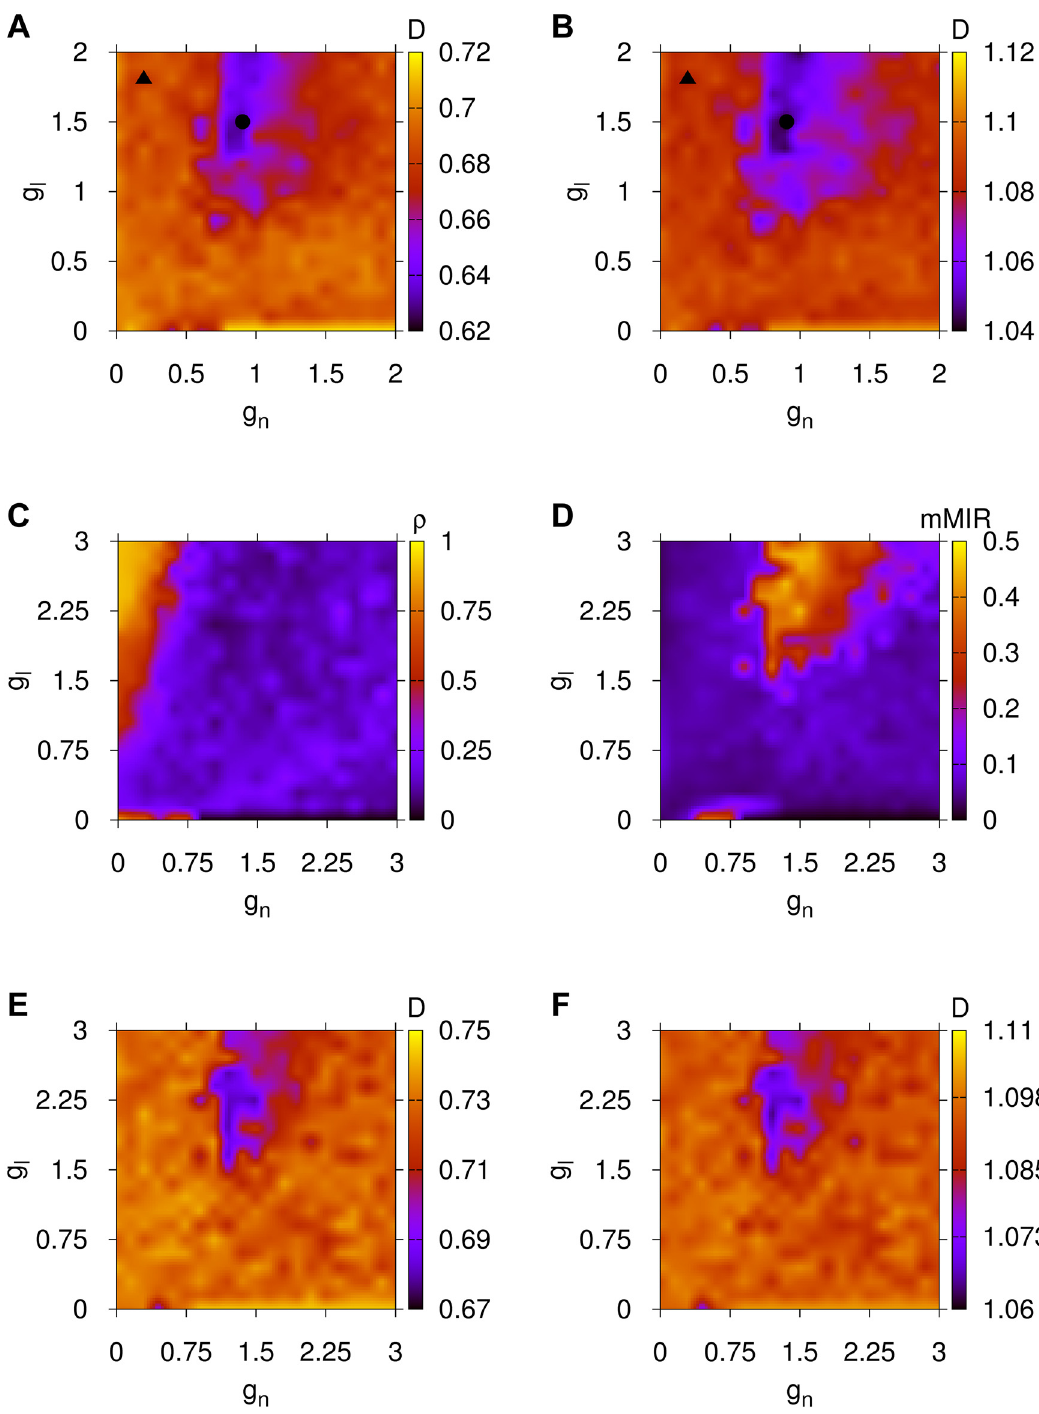
Fig 5. Spectral distances between the network topology of the C.elegans , humans and evolved networks and, global synchronization and information flow capacity properties for an evolved BDN of 120 neurons. Panel (A): Parameter space for the spectral distance D between the C.elegans brain network and the averaged model for brain network evolution of 60 neurons and 6 small-world clusters and, panel (B) similarly for the spectral distance between the averaged brain network of the six human subjects and the same averaged network created by our brain network evolution. ▲ denotes case A and ● case B , both explained in Materials and Methods, Subsection Brain Network Evolution Promotes Global no Hebbian-like and, Local Hebbian-like and no Hebbian-like Evolution Learning Processes. Both panels to be compared with Fig 3(B). Panel (C): Parameter space for the synchronization ρ and panel (D) for the mMIR of evolved networks using our brain network evolution process with 120 neurons. Panels (E), (F) are similar to (A), (B) for the spectral